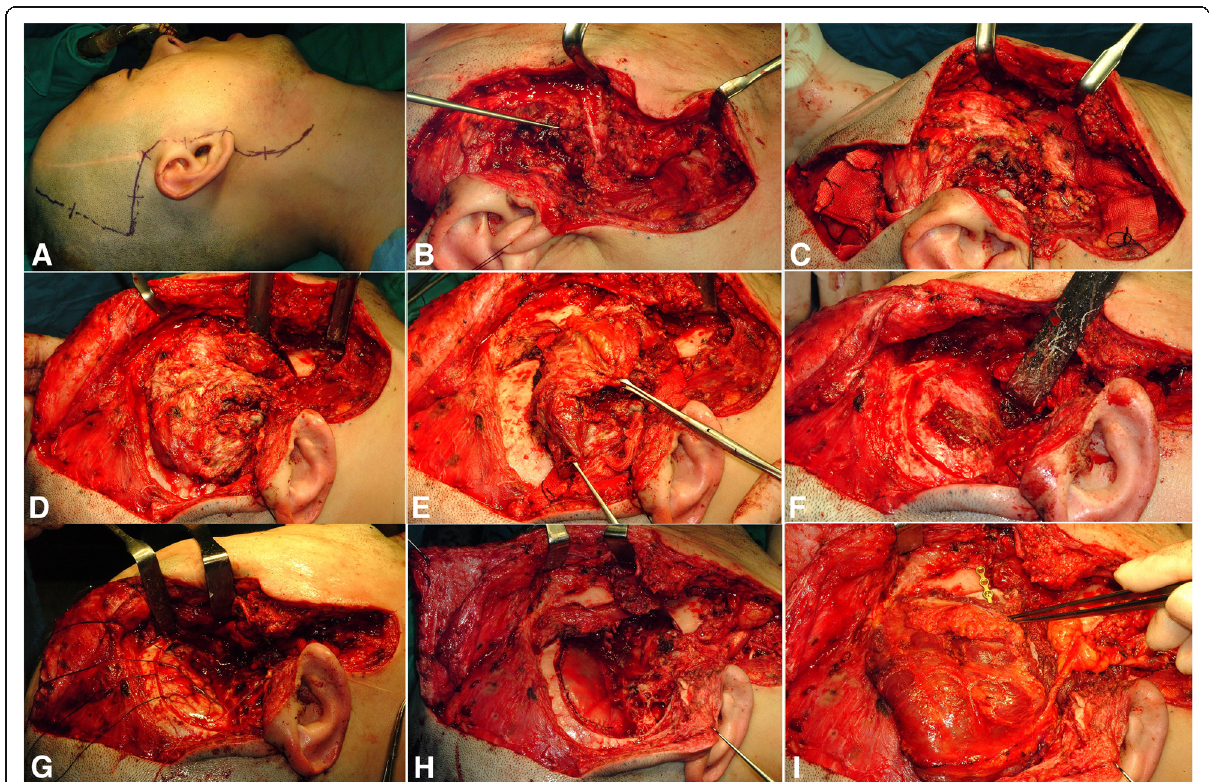
Fig. 4 The modified zygomatico-transmandibular approach to the infratemporal fossa with latissimus dorsi muscular free flap reconstruction, showing the incision line ( a ), mobilization of the parotid gland ( b ), pathologic mass exposure by orbito-zygomectomy ( c ) and coronoidectomy ( d ), whole mass removal ( e ), the temporal or skull base craniotomy state ( f ), and dura mater repair with latissimus dorsi free flap reconstruction ( g to i